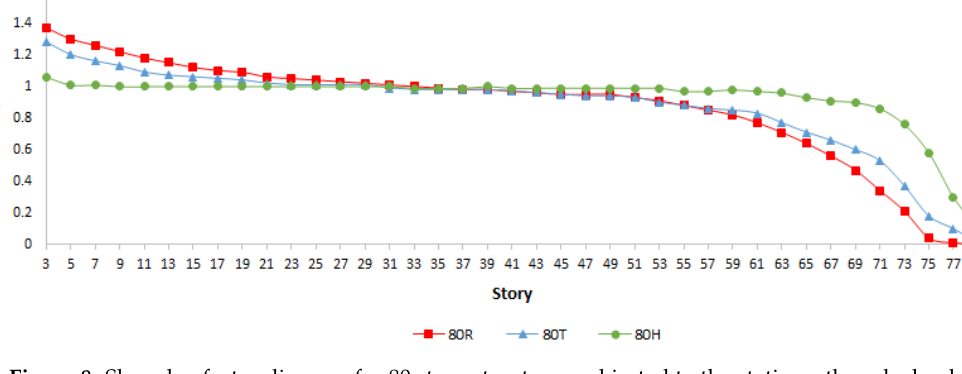
Figure 8. Shear lag factor diagram for 80 story structures subjected to the static earthquake load.